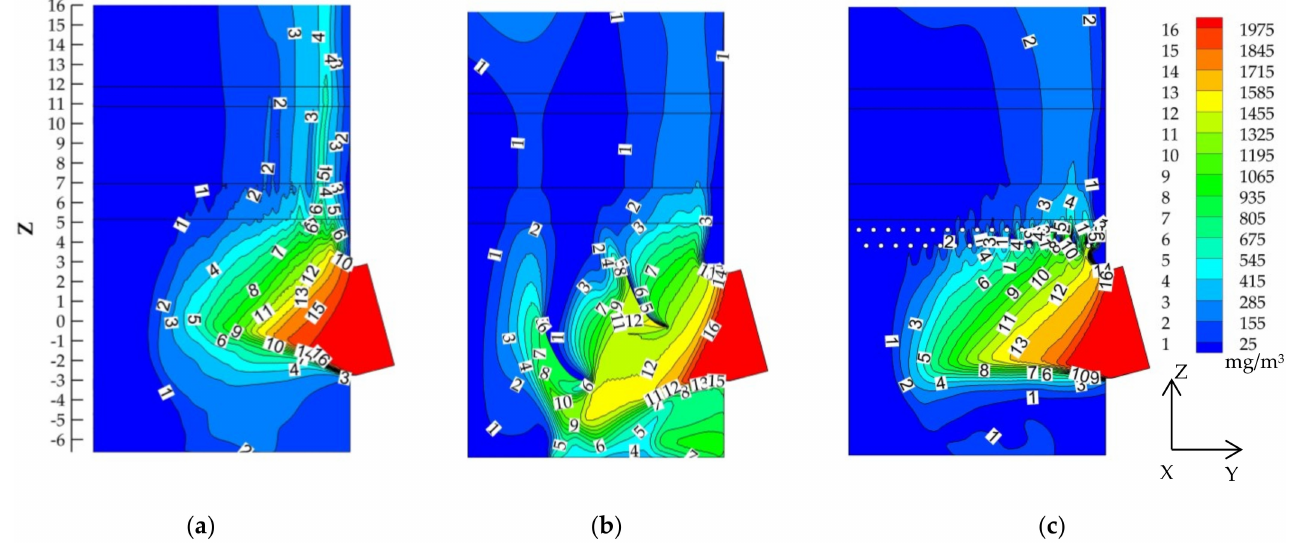
Figure 12. Concentration distribution of SO 2 at X = 0 plane: ( a ) OST; ( b ) DST; ( c ) RBST.